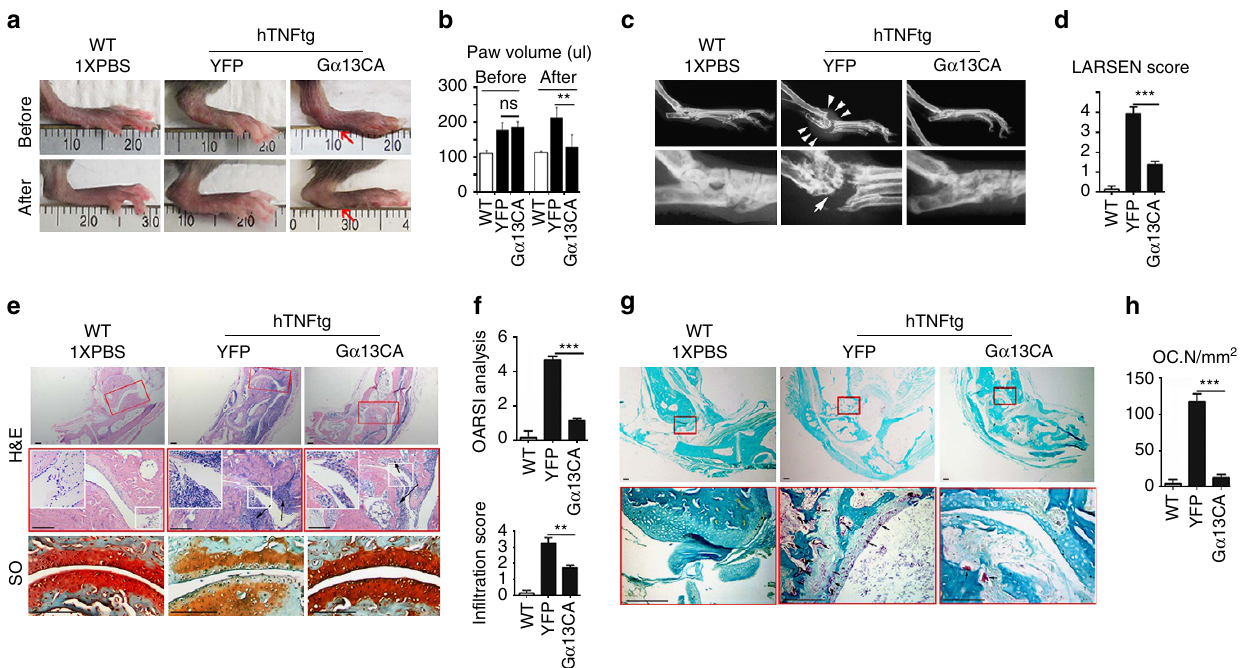
Figure 6 | G a 13 protects Rhematoid arthritis mice from inflammatory bone loss. ( a – h ) Histology analysis of 18-week-old male WT and hTNFtg Rheumatoid arthritis mouse ankles. hTNFtg mouse ankles were injected with AAV-G a 13CA or AAV-YFP. ( a ) Photographic images before and after AAV treatment. The red arrows showed paw swelling is relieved after AAV-G a 13CA treatment. ( b ) Quantification of hind paw volume in a ; N ¼ 8. ( c , d ) Radiographic images; White arrows mark bone destruction. ( d ) Quantification of bone destruction (Larsen grade) in a ; N ¼ 8. ( e ) H&E staining (black arrows mark monocyte infiltration) and Safranin O (SO) staining (black arrows mark articular cartilage damage). ( f ) Quantification of cartilage damage (OARSI grade) and inflammation (infiltration score) in e ; N ¼ 8. ( g ) TRAP staining; black arrows mark TRAP positive cells. ( h ) Quantification of osteoclast number (Oc.N) in g ; N ¼ 8. Results were expressed as mean ± s.d.; * P r 0.05; ** P r 0.01; *** P r 0.001 (Student’s t -test). scale bars in e , g 200 m